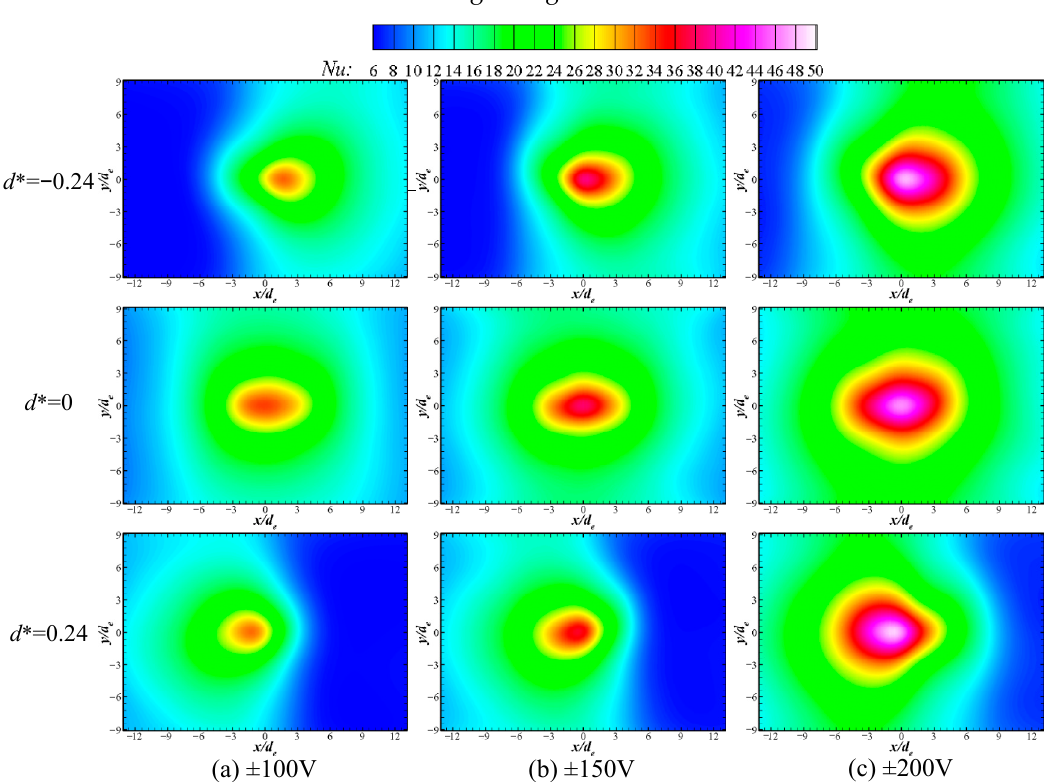
Figure 9. Nu contours at different driving voltages and slider locations.